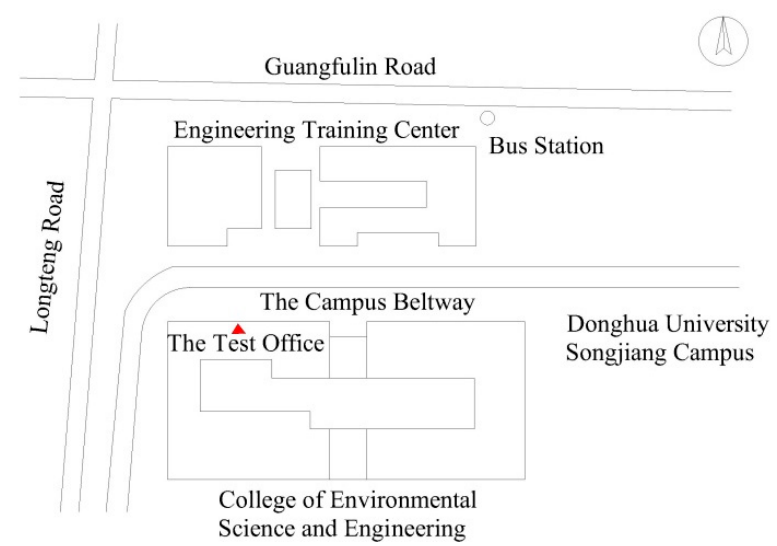
Figure 1. Location of the tested office building.